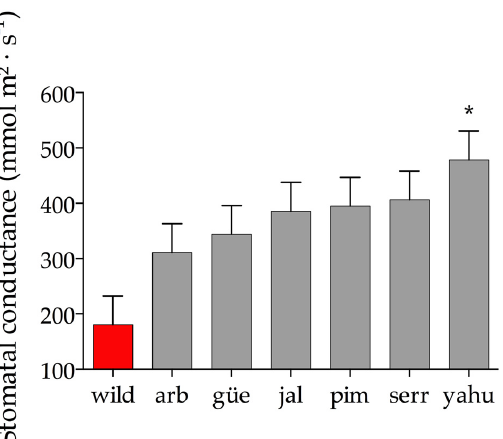
Figure 2. Univariate ANOVA was used to compare the the stomatal conductance of wild populations and cultivated varieties. Red bars indicate the mean and 1 ± SE for the wild variety. Gray bars indicate the mean and SE of the cultivated varieties. The asterisks indicate which cultivated variety significantly differs from the wild variety after Tukey’s HSD test ( α =